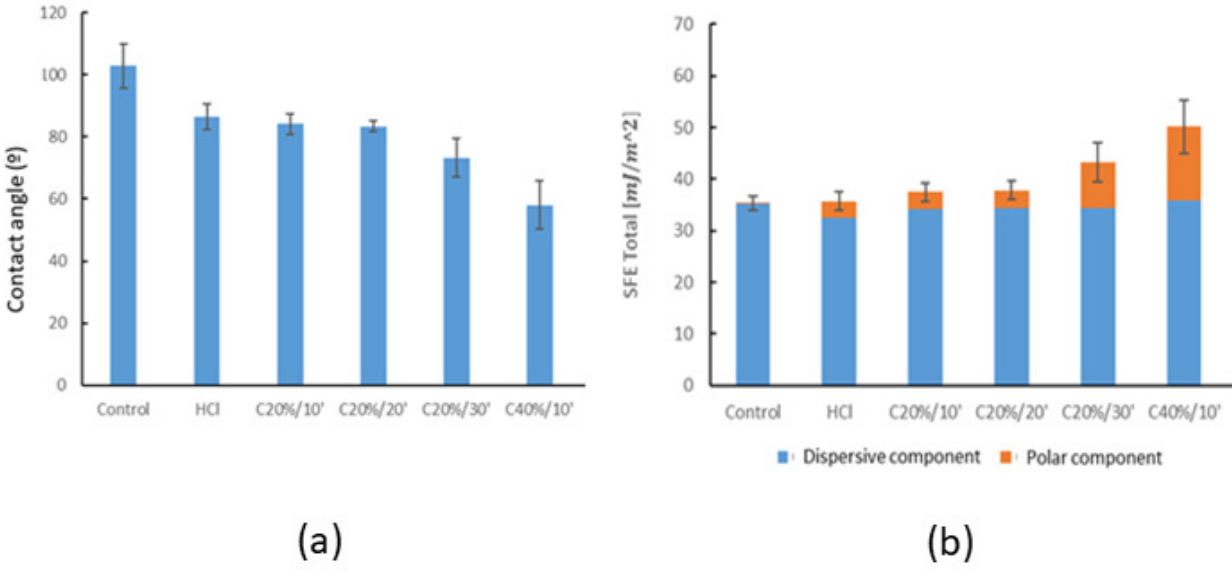
Figure 4. CA values ( a ) and SFE values ( b ) of cp. Ti treated with different passivation conditions.